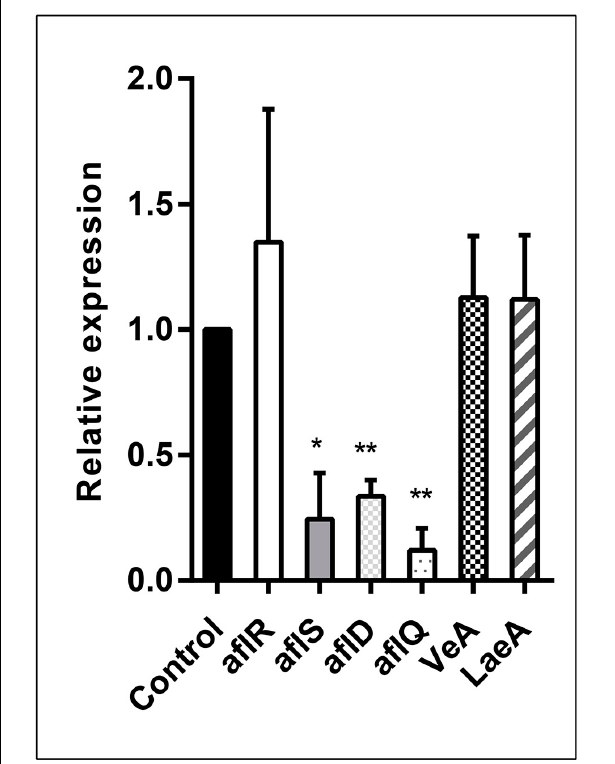
FIGURE 4 | Relative expression values of the aflR , aflS , aflD , aflQ , VeA, and LaeA genes in A. flavus at 28 ± 2 ◦ C after 3 days. The β -tubulin gene was used as an internal control to normalize the expression data. The error bars represent the standard deviations from three independent experiments with three replicates each. Values in each column followed by one ( p < 0.05) or two ( p < 0.01) asterisks are significantly different from the control according to the Student’s t